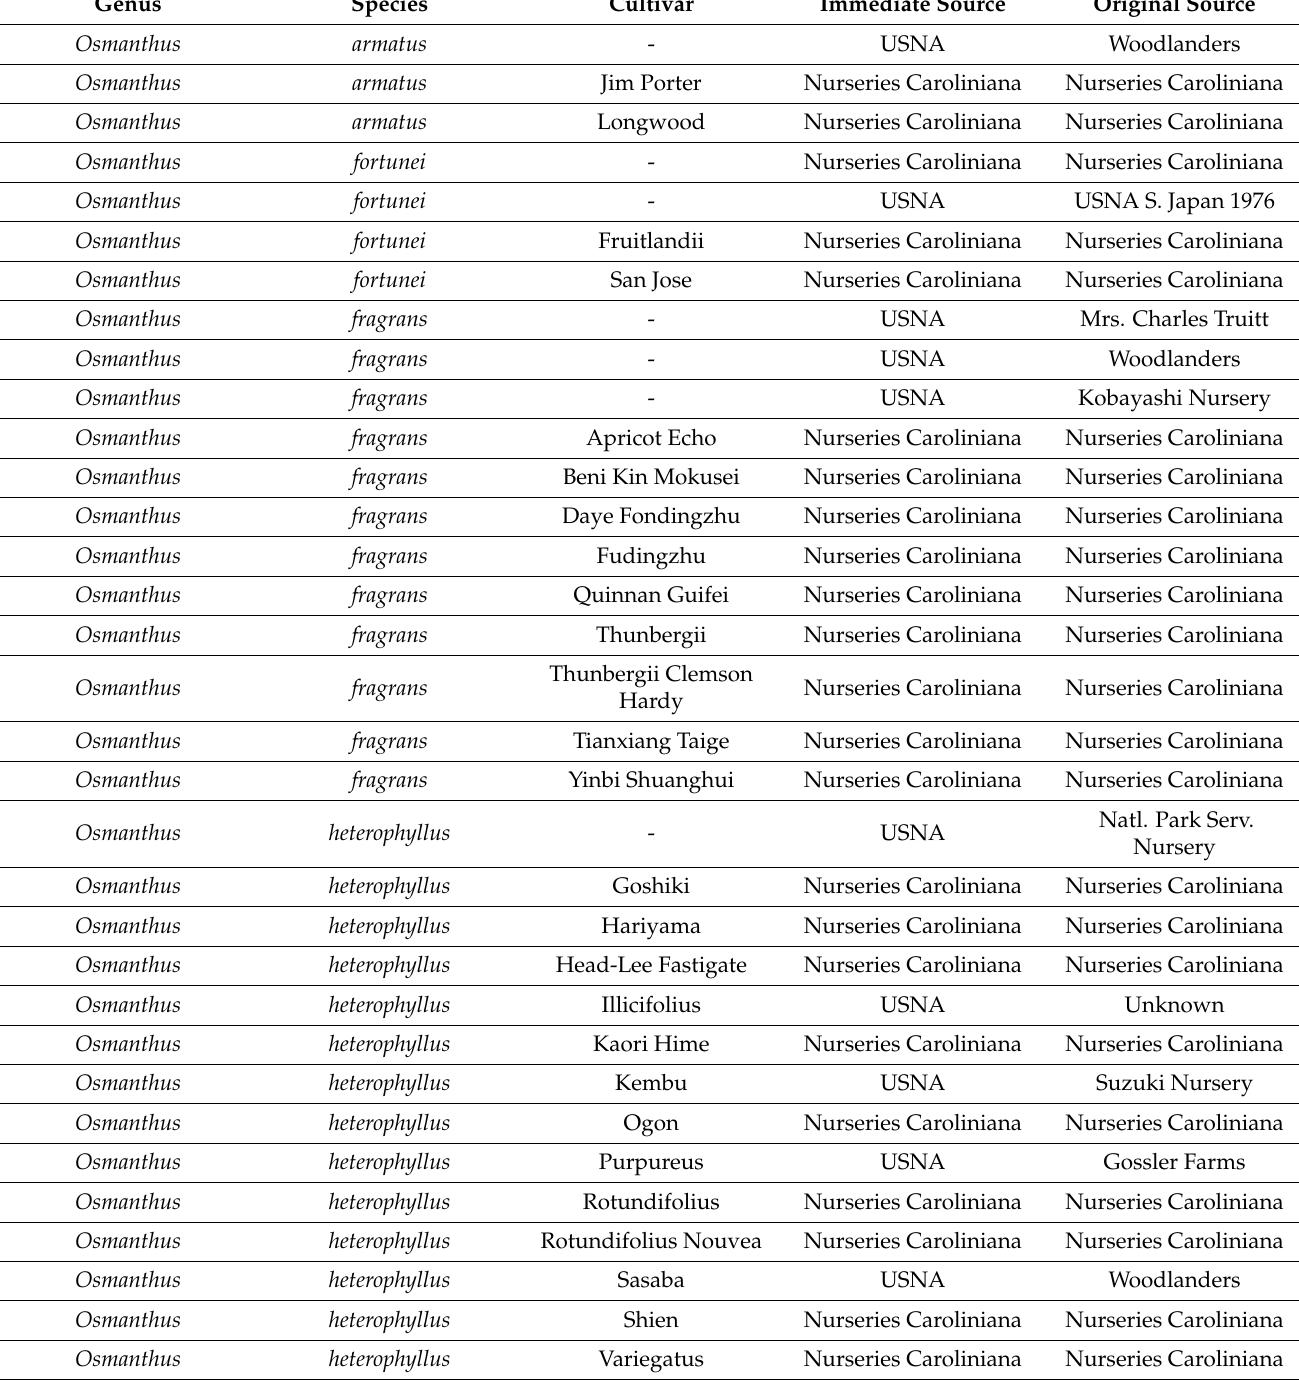
Table 1. Thirty-three accessions representing four species of Osmanthus used for genome sizing, floral morphology, pollen viability, and/or incompatibility studies at the U. S. National Arboretum in McMinnville, TN, USA. A dash (-) indicates seedling (i.e., not a named